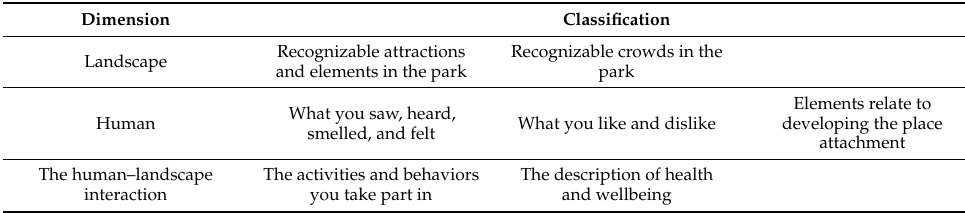
Table 3. Encoded classification table of